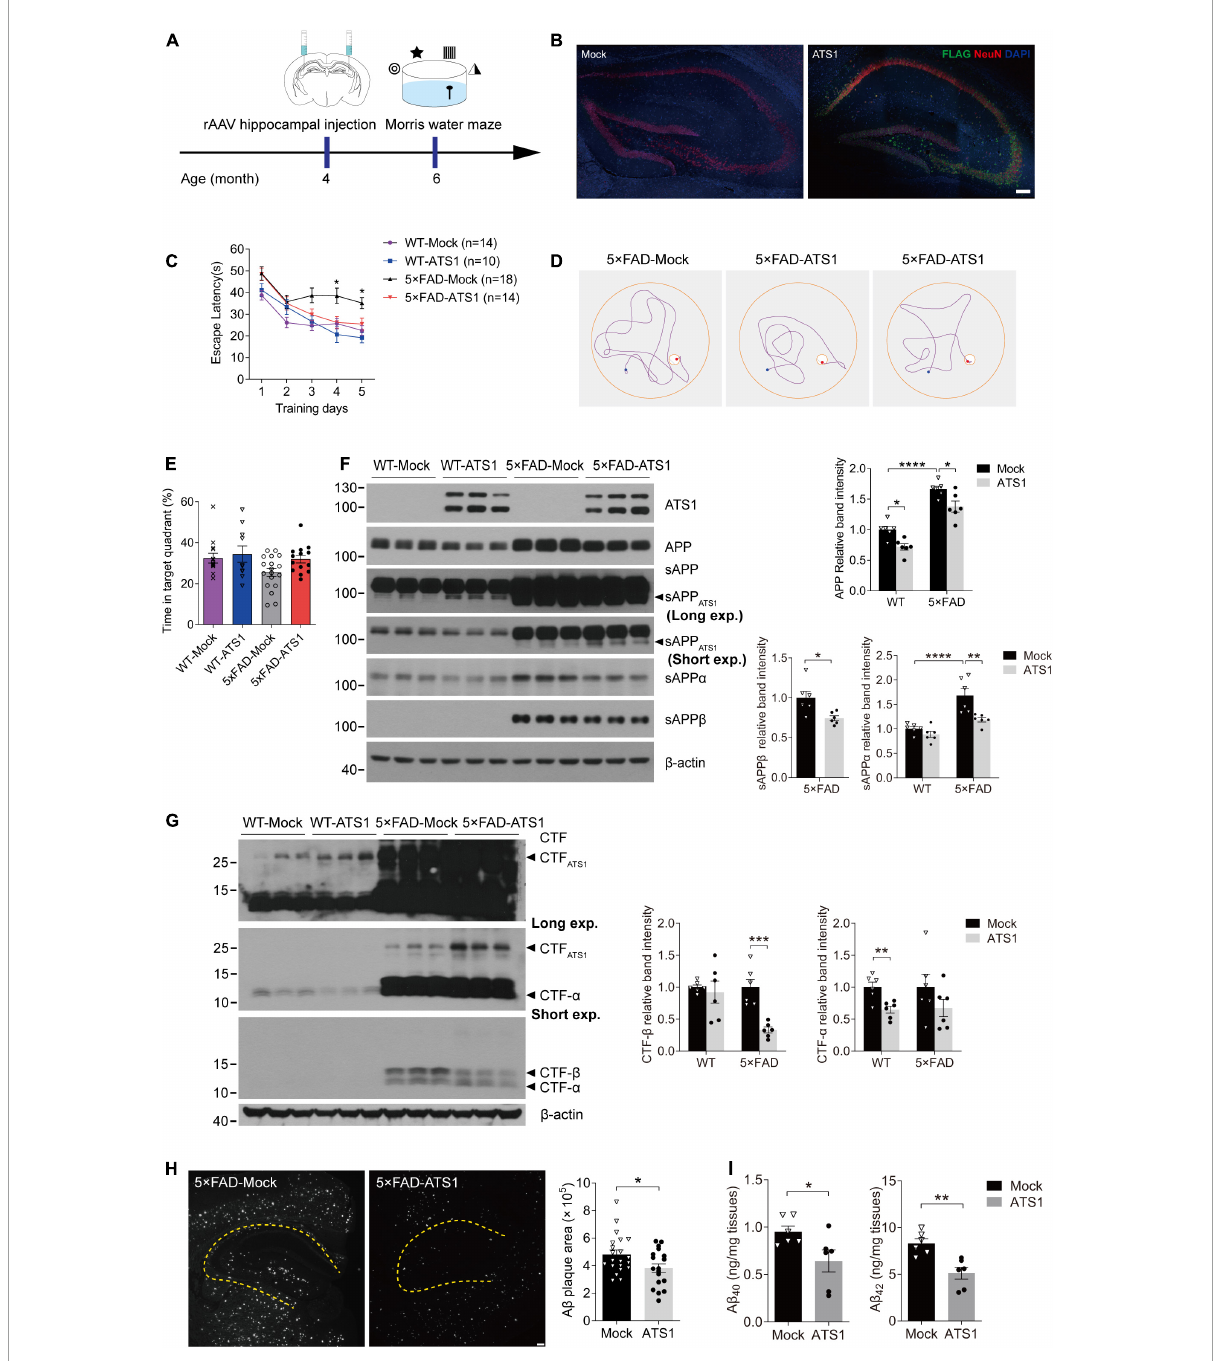
FIGURE6 High-level ATS1 in hippocampus attenuated amyloid load of 5 × FAD mice and improved the cognitive behavior. (A) Scheme of rAAV injection and Morris water maze test performed on 5 × FAD mice. (B) Expression of rAAV- ATS1 - FLAG and Mock. Nuclei (by DAPI), ATS1 (by FLAG), neuron (by NeuN) were labeled in hippocampus. Scale bars, 100 µ m. ( C–E ) Morris water maze tests were performed on WT and 5 × FAD mice 2 months after injection of rAAV ( n = 14 for WT-Mock, n = 10 for WT-ATS1, n = 18 for 5 × FAD-Mock and n = 14 for 5 × FAD-ATS1). (C) The escape latency was recorded during the 5-day training, showing that 5 × FAD mice with ATS1 spent less time during the learning trial when compared with mock control [DAY 4, P < 0.05, 5 × FAD-ATS1 vs. 5 × FAD-Mock; DAY 5, P < 0.05, 5 × FAD-ATS1 vs. 5 × FAD-Mock. Two-way repeated measures ANOVA, day × group F (3, 52) = 1.153, P > 0.05, no significant interaction; group F (3, 52) = 16.820, P < 0.0001]. (D) Representative navigation routes of 5 × FAD-Mock and 5 × FAD-ATS1 mice to the hidden platform during the last day of training. (E) The probe trial was performed 24 h after the last trial of hidden platform task, and the percentage of searching time in the target quadrant indicated that